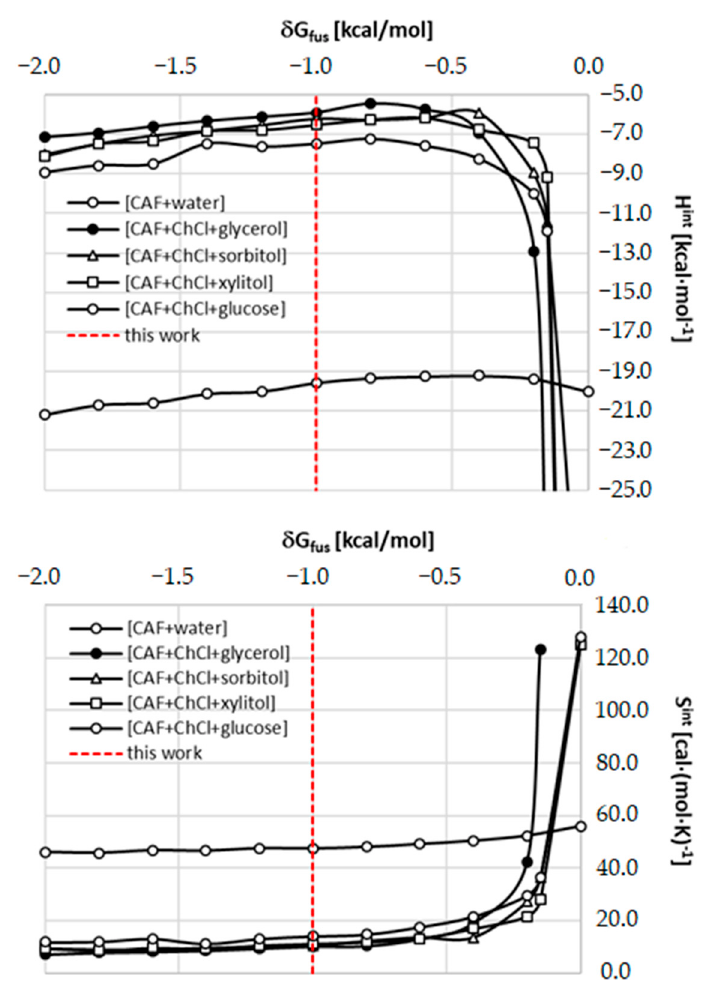
Figure 13. The correlation between the COSMO-RS DARE interaction parameters and fusion data Δ G fus = Δ G° fus + δ G fus , used for solubility computations. The value of Δ G° fus corresponds to experi- mental fusion data provided in Table 3.